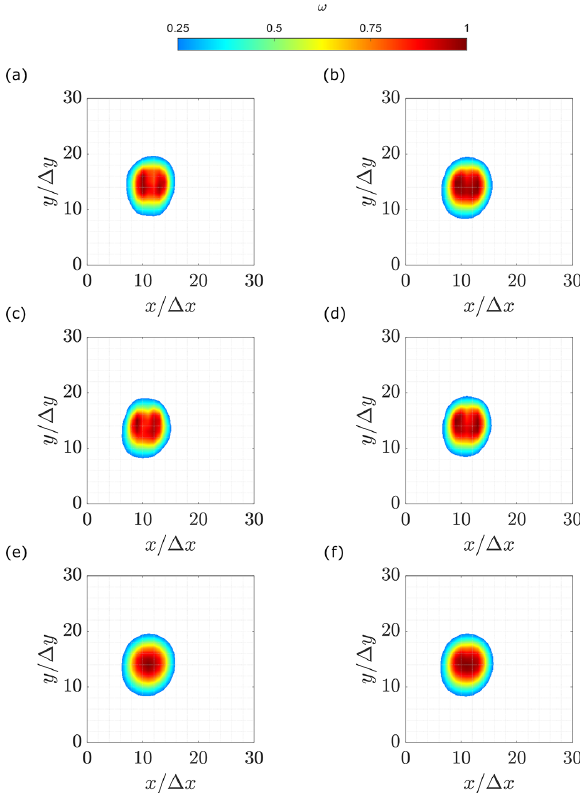
Figure 8. Normalized Q -criterion magnitude on the area of interest. (a) Backward difference. (b) Central difference. (c) Forward differ- ence. (d) Richardson extrapolation. (e) Least square. (f) Circulation method.